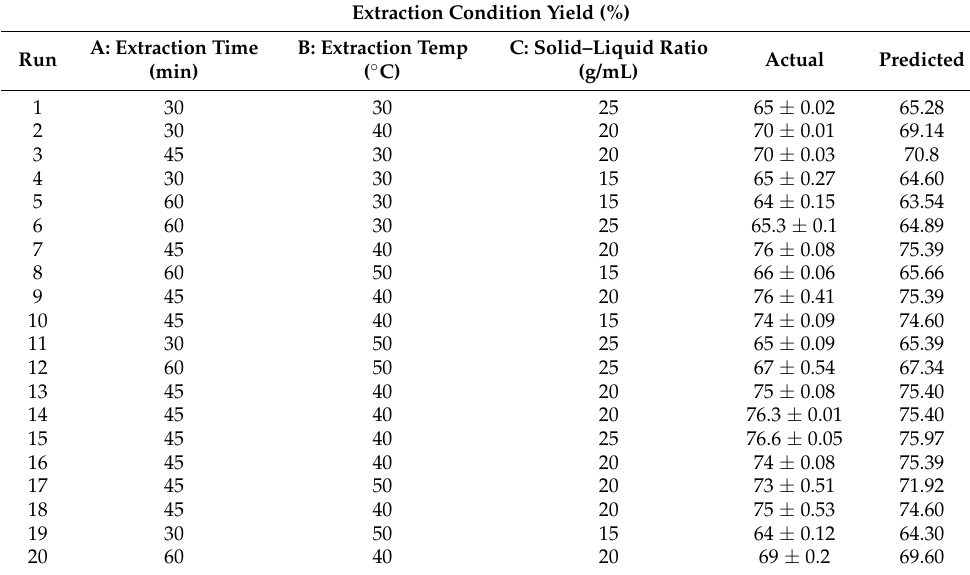
Table 2. FCCCD experimental design and the response.